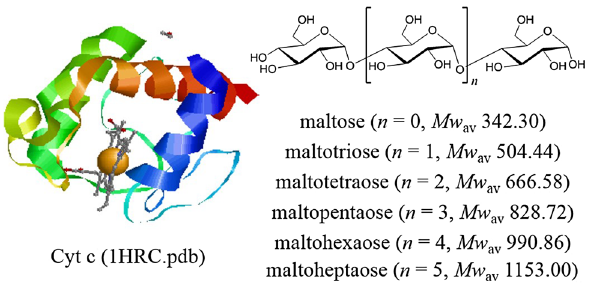
Fig. 1 Structures of Cyt c of a ribbon diagram were adapted from 1HRC.pdb [1] and maltooligosaccharides. The diagram was created using the RasMol program [2]